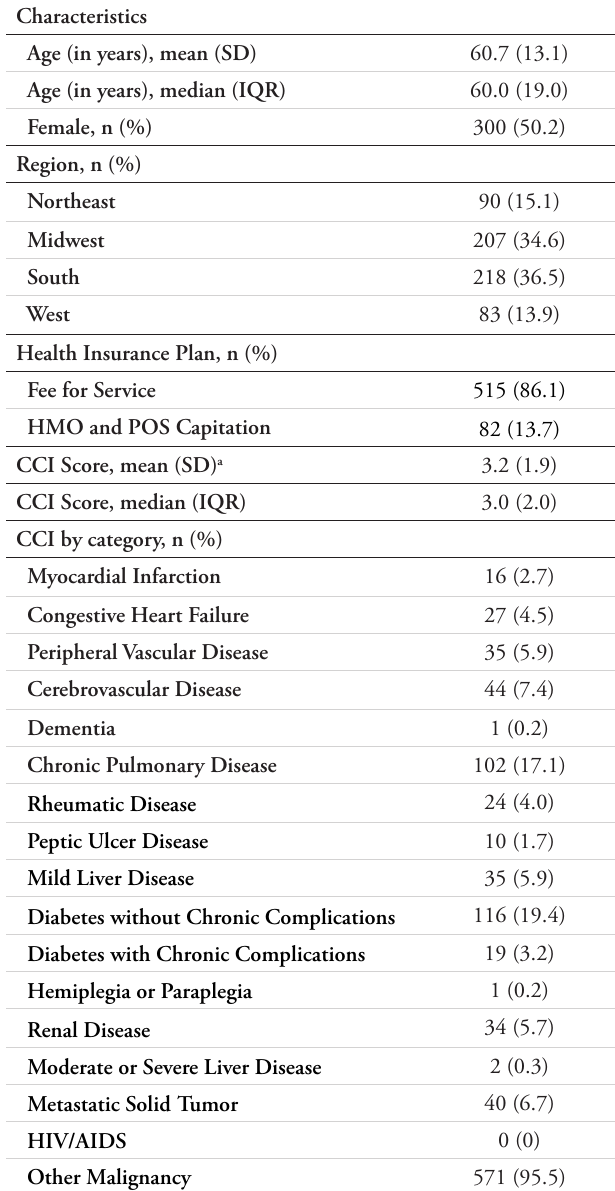
Table 1. Patient Characteristics in Baseline Period (N=598)